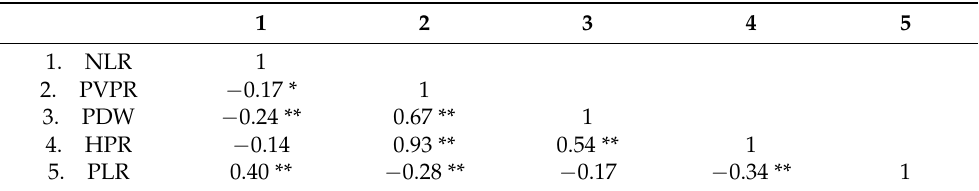
Table 2. Sperman rank-order correlation of inflammatory markers.